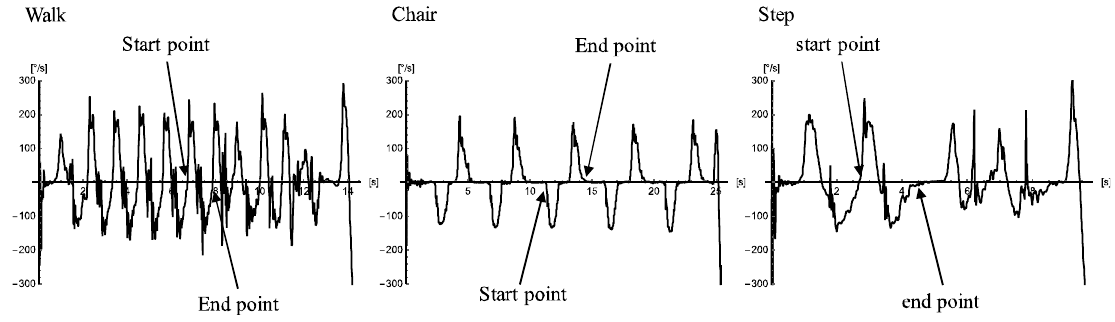
Figure 2. Examples of each cut off point for gyroscope data of frontal axis at thigh.